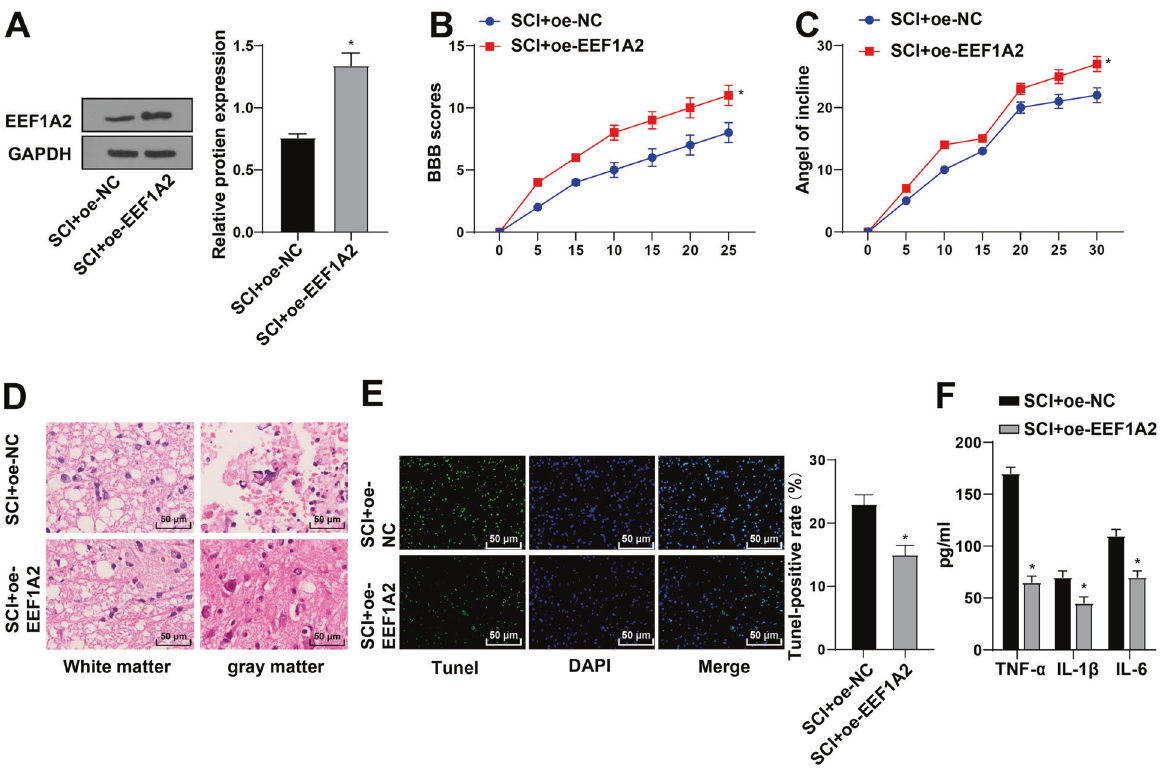
Fig. 2 EEF1A2 overexpression inhibited SCI progression in rats. A expression of EEF1A2 in spinal cord tissues detected by Western blot; ( B ) locomotor ability detected by BBB locomotor rating scale; ( C ) neuronal function detected by inclined plane test; ( D ) pathological conditions of spinal cord assessed by HE staining; ( E ) apoptosis of spinal cord tissues detected by TUNEL staining; ( F ) expressions of TNF- α , IL-1 β and IL-6 detected by ELISA. Data were expressed as mean ± SD and analyzed using independent t test, N = 5. * vs SCI + oe-NC group, p <